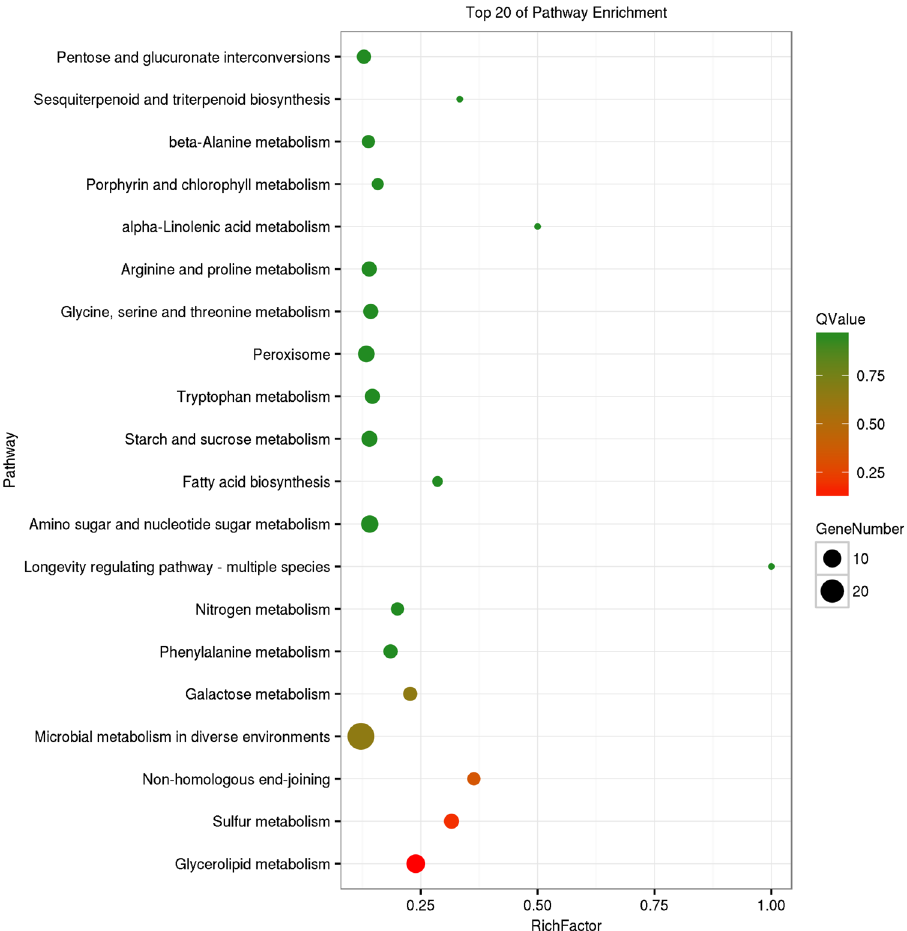
Figure 3. KEGG enrichment diagrams of gene of module brown. Vertical axis represents pathway entries, and Rich Factor on the horizontal axis refers to the ratio of the number of genes of DEGs in the pathway to the total number of genes of all genes in the pathway. The higher the Rich Factor value is, the higher enrichment degree is. Size of the circle corresponds to the number of enriched genes, and the larger the circle, the more genes there are. QValue is the p -value after multiple hypothesis test correction, which ranges from 0 to 1, corresponding to the gradual change of red to green. The closer it is to zero, the more red it is, and the more significant the enrichment is. This figure is plotted with the first 20 pathway of QValue of from smallest to